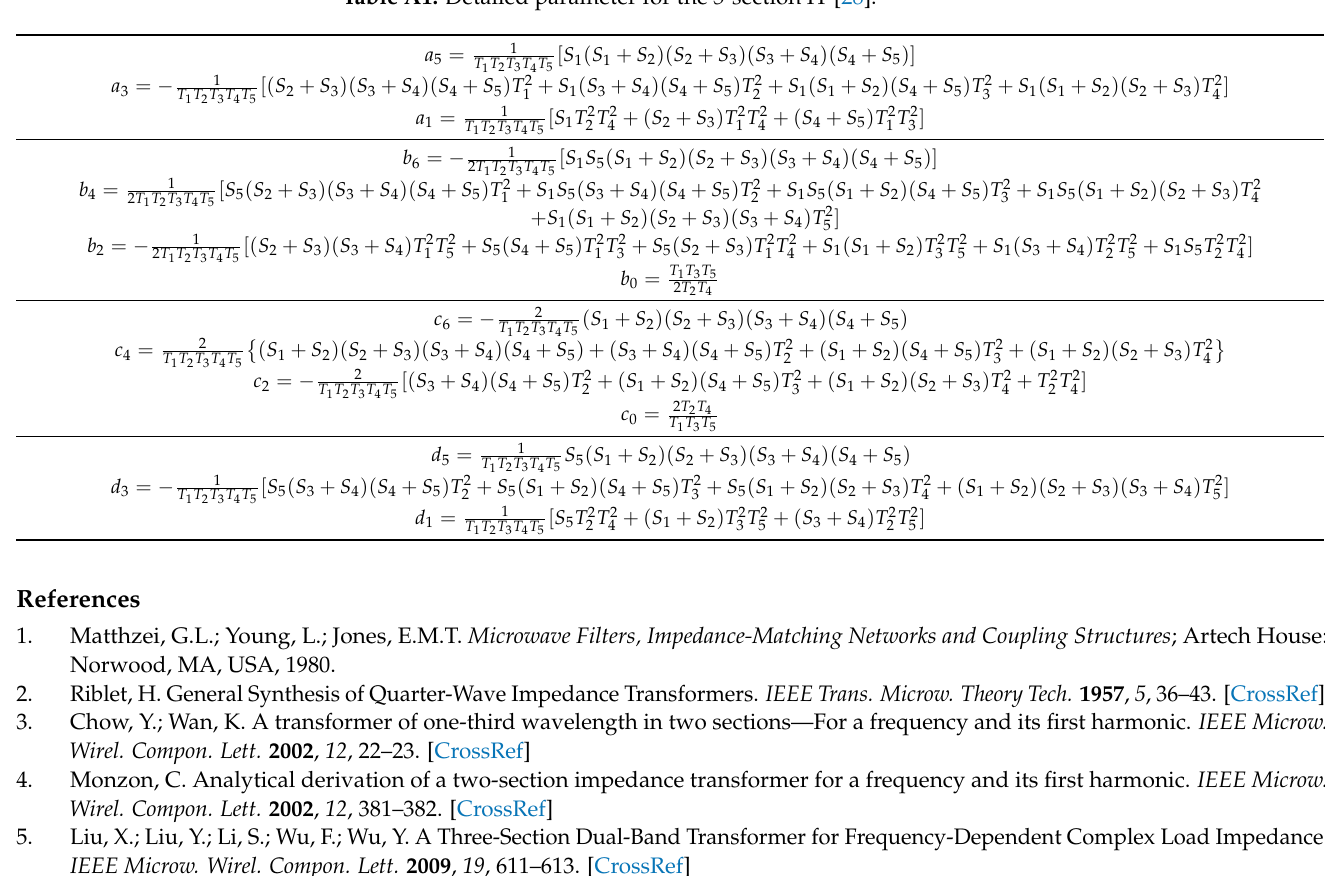
Table A1. Detailed parameter for the 5-section IT